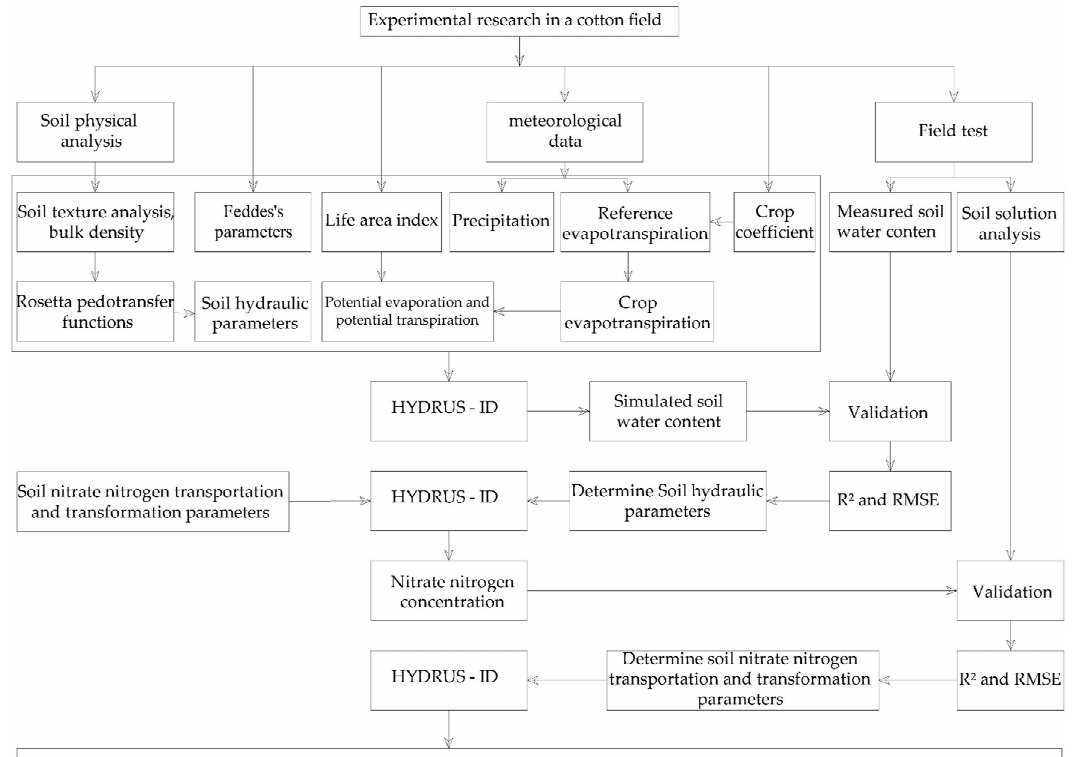
Figure 3. Flowchart of the outline of the methodology.